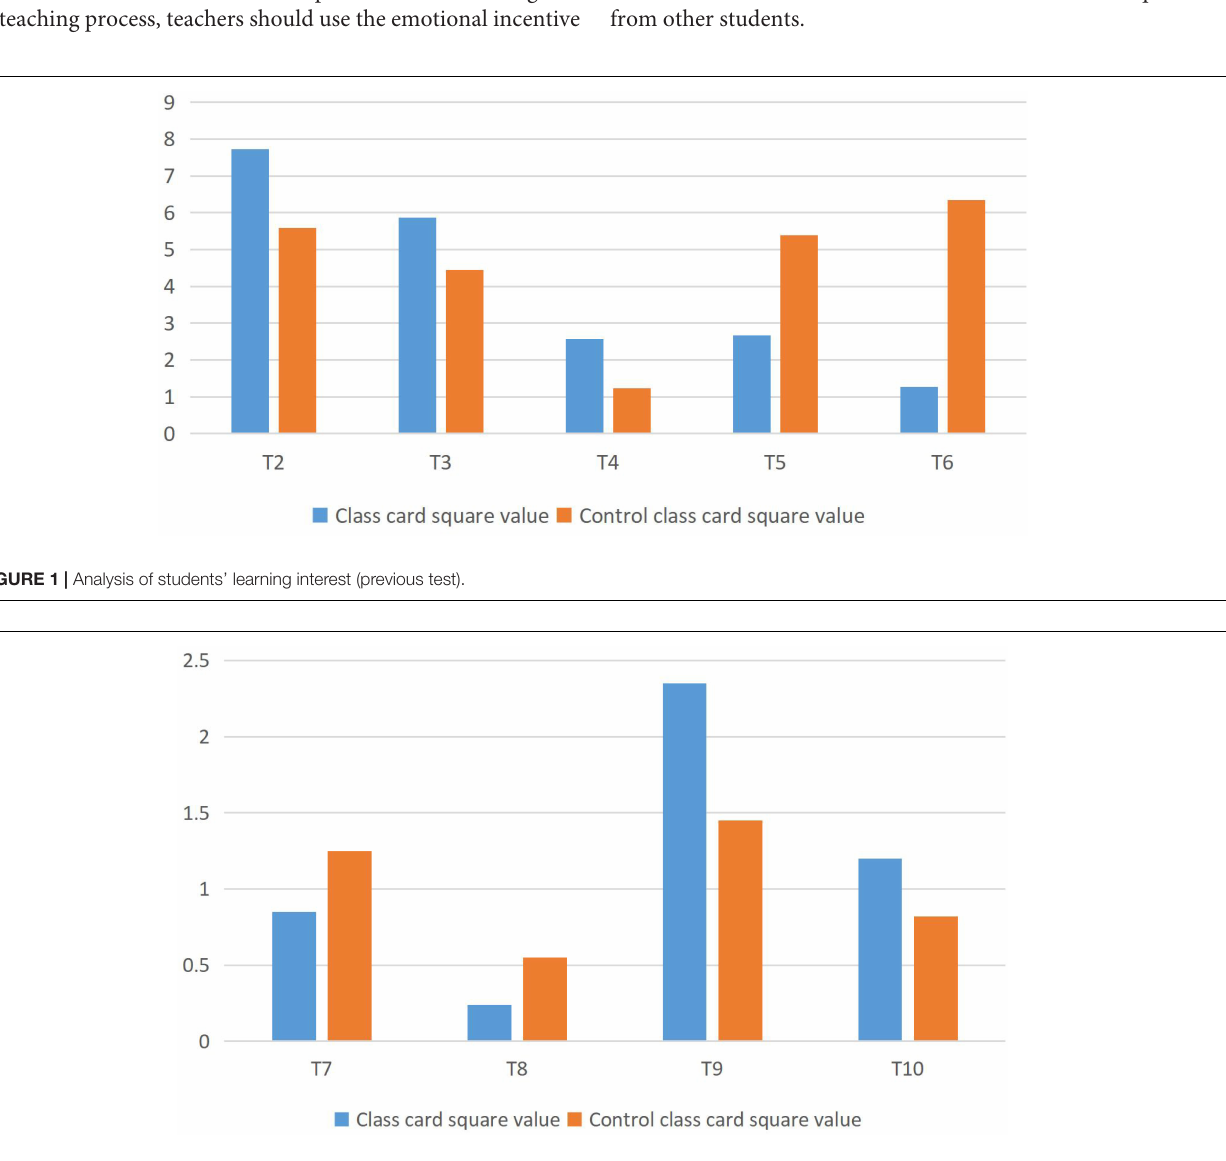
FIGURE 2 | Analysis of students’ learning attitude